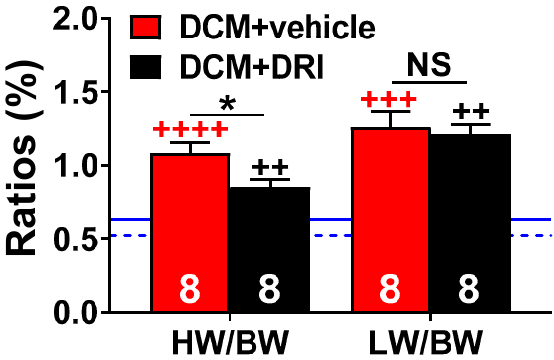
Figure 3. Morphometric changes at 90 days. Heart weight to body weight (HW/BW, %) and lung weight to body weight (LW/BW, %) ratios at a 90-day collection of censored subgroups. DCM control (DCM+vehicle) and aliskiren treated (DCM+DRI) group sizes are shown. For reference, the mean ratios for wild-type mice (WT, n = 4) for HW/BW are shown as a blue dashed line and the LW/BW as a solid blue solid line. Data were analyzed with two-tailed unpaired t-test and represented as mean ± SE. Not significant (NS), ++ p < 0.01, +++ p < 0.001, ++++ p < 0.0001 (red, WT vs. DCM+vehicle; black, WT vs.